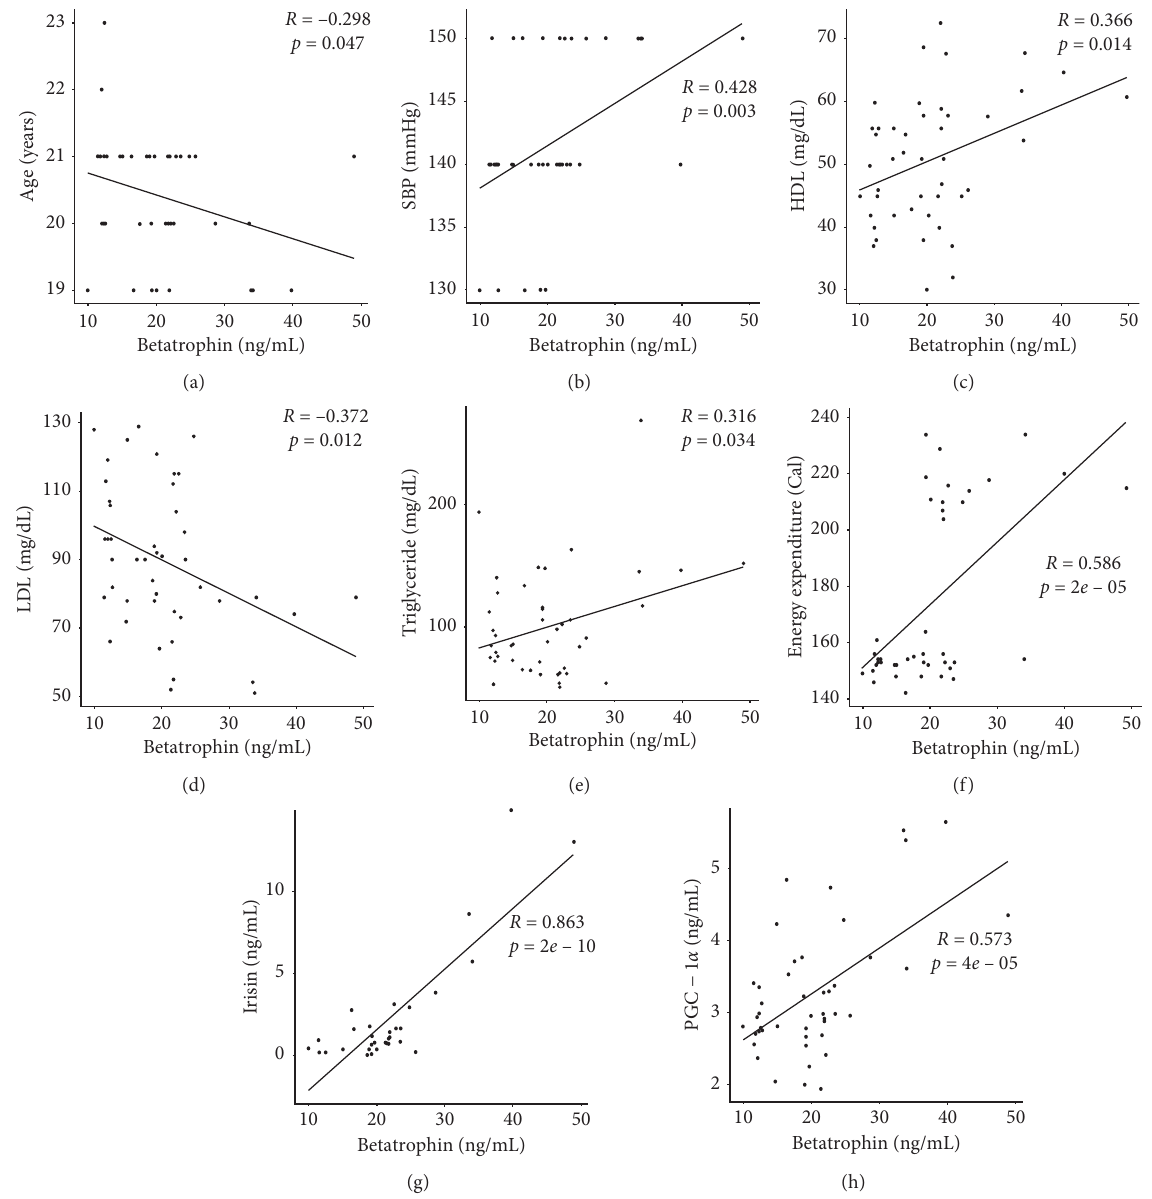
Figure 3: Univariate correlations with plasma betatrophin. The significant linear correlation between parameters was visualized in the plot model ( p ≤ 0 .